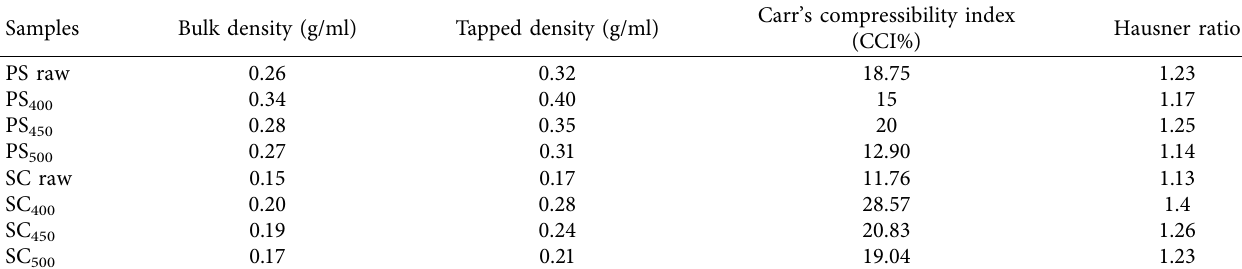
Table 3: Bulk density and fowability indices of raw and pyrolysis biomasses.